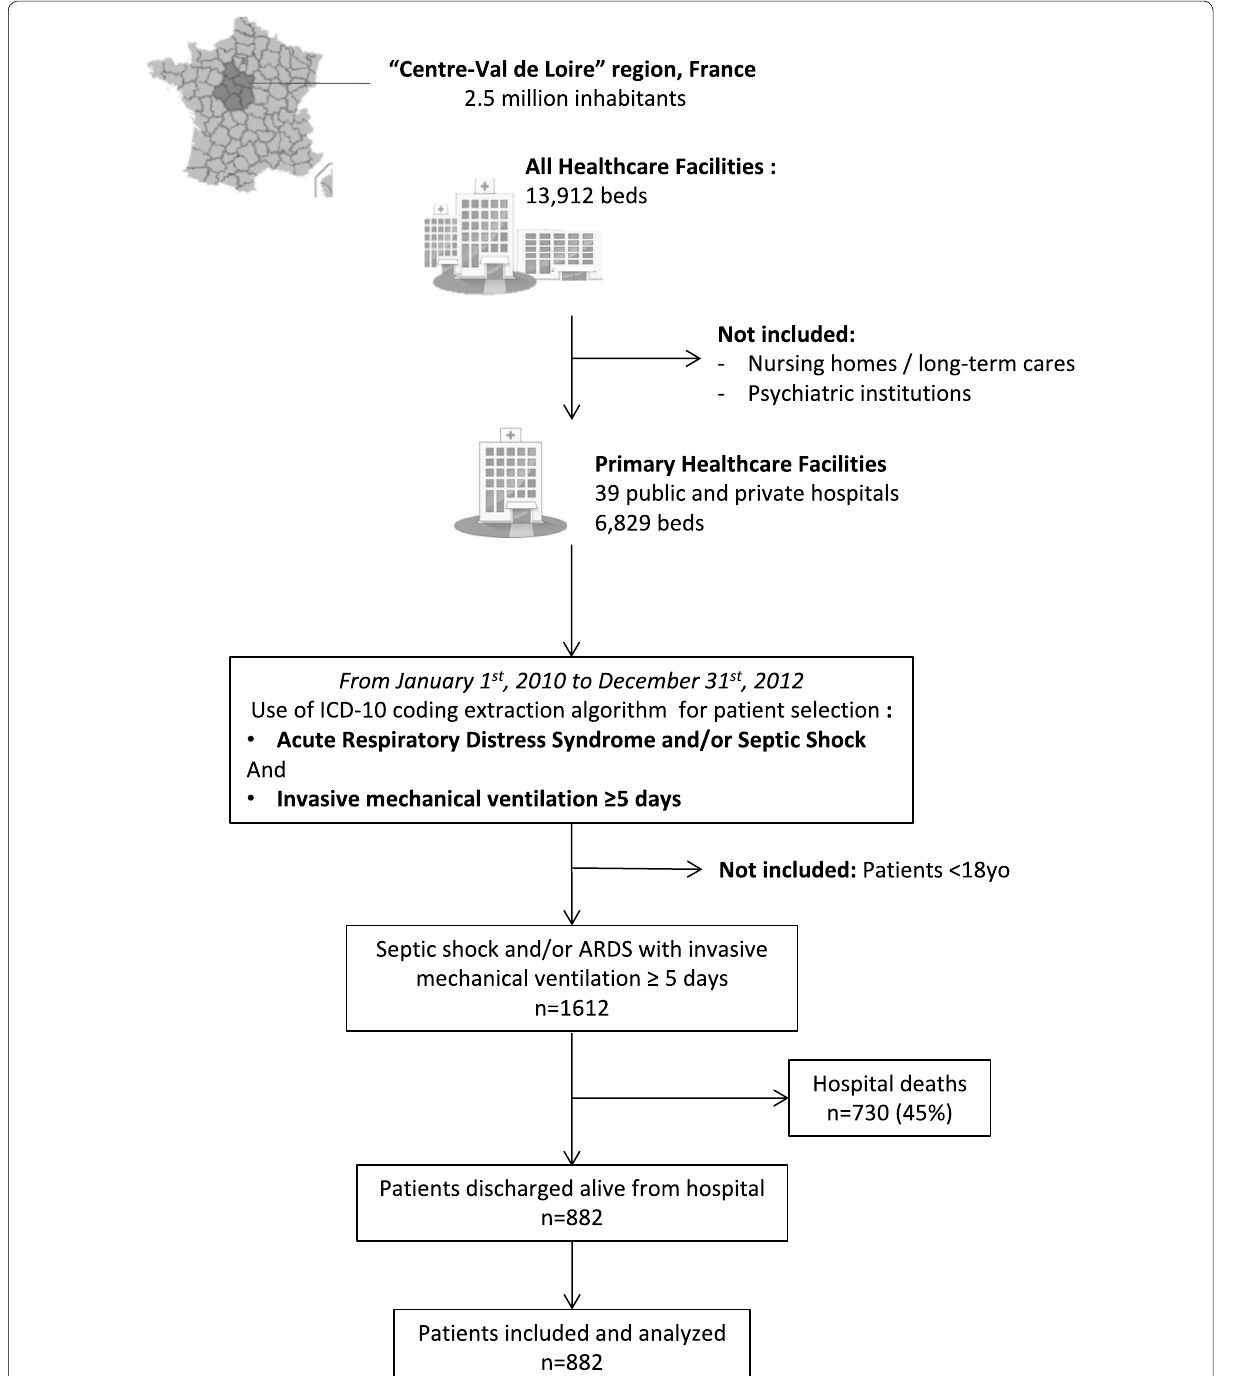
Fig. 1 Flowchart describing data extraction and patients’ retrospective process from the database, during the study period. ARDS acute respiratory distress